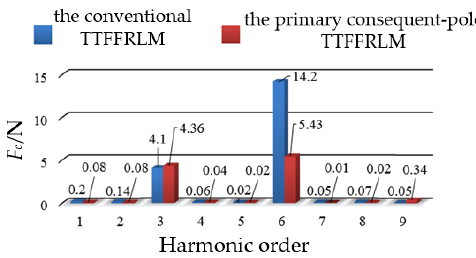
Figure 13. Harmonic components of the three-phase detent force of the two machines.